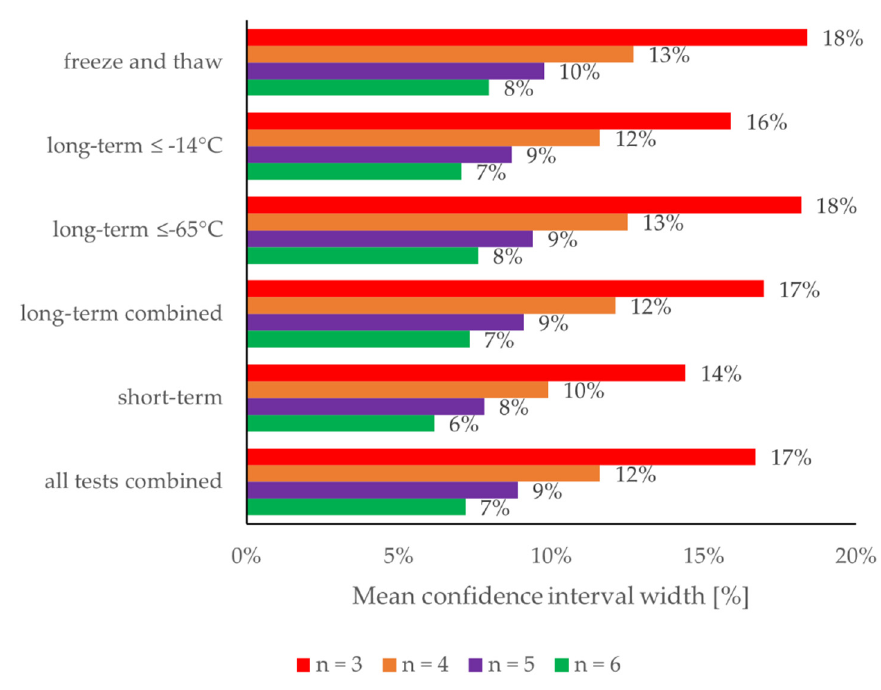
Figure A3. Retrospective study: Relation between mean confidence interval width and type of stability test.